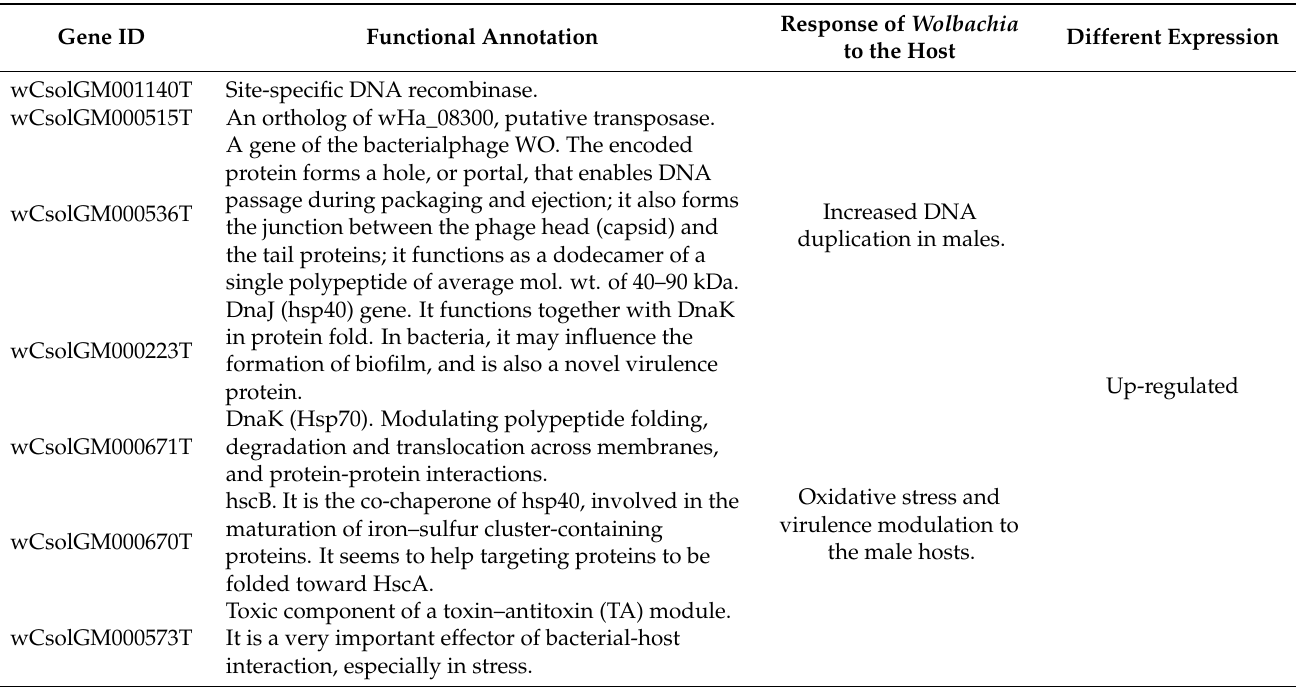
Figure 3. RT-qPCR assay of differentially expressed Wolbachia genes in female and male hosts. F: Female (control); M: Male (treatment); *: 0.01 < p value < 0.05; **: p value < 0.01. Table 2. Information on the validated Wolbachia genes that are differentially expressed between female and male hosts samples. (Male: treatment; Female: control).